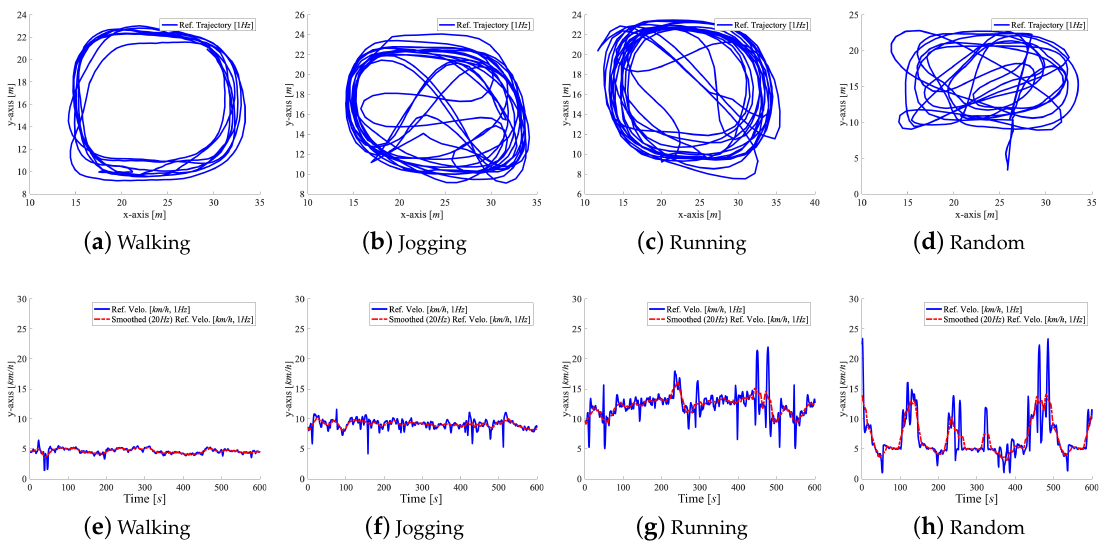
Figure 7. Exemplary segment bundle of one user. Each datapoint represents a single window. The upper row shows reference trajectories (at 1 Hz) and the bottom row shows v ref (at 1 Hz).